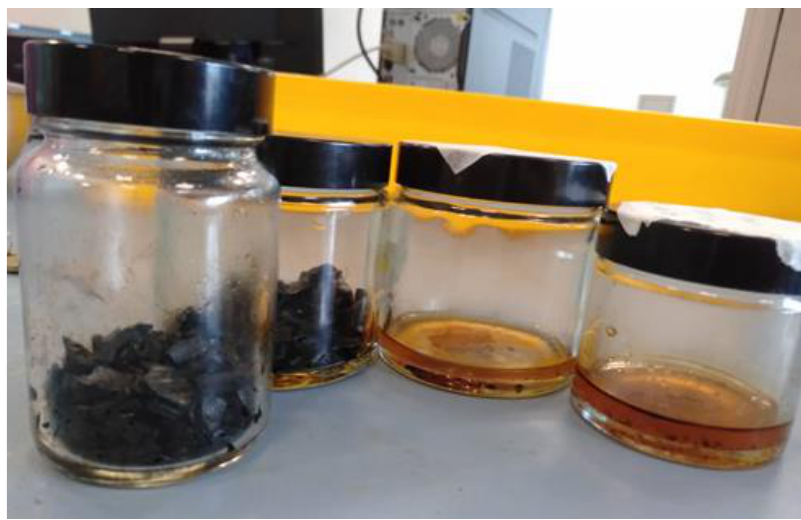
Figure 3: Samples of bio-char and bio-oil obtained from